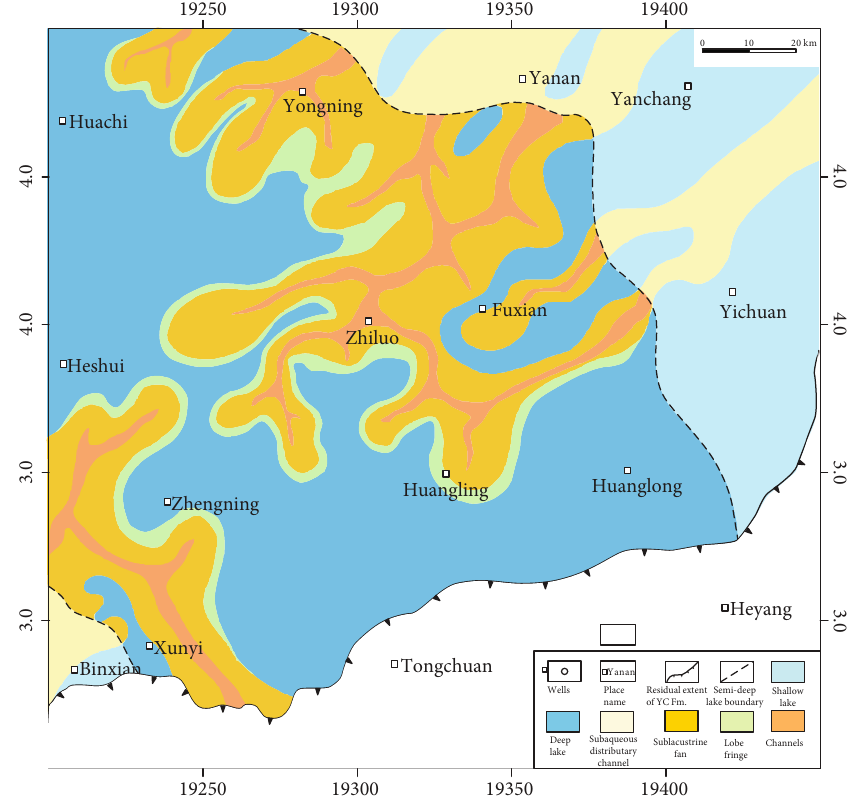
Figure 9: Sedimentary facies map of Chang 72 interval in the study